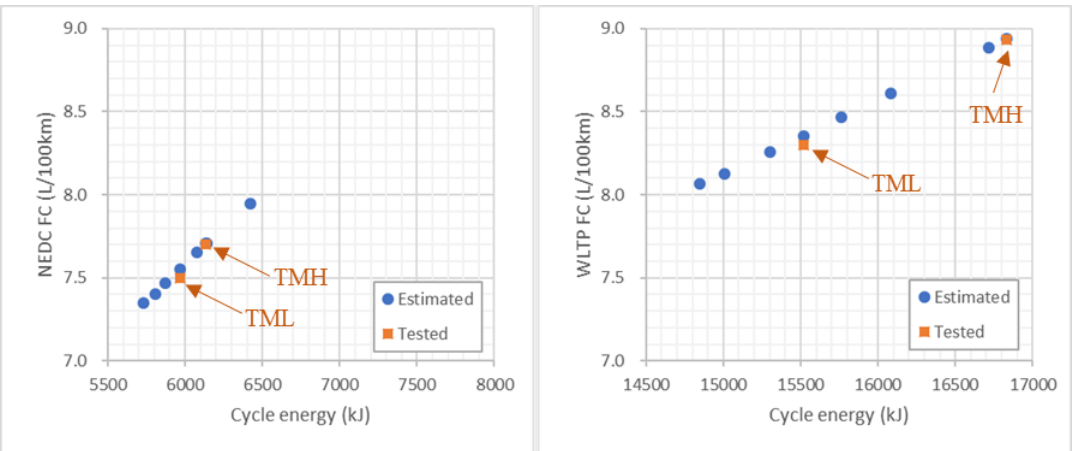
Figure 8. Fuel consumption under NEDC and WLTP according to the cycle energy of 1.6-L gasoline T-GDI .